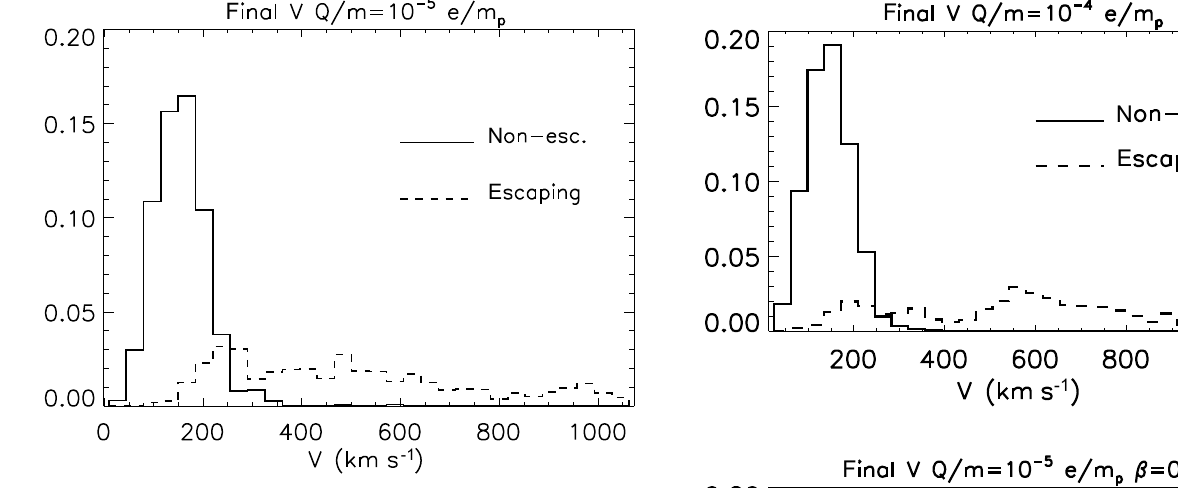
Figure 4. Distribution of the final velocity for non-escaping and es- caping particle populations obtained in the CME model for a sample of 4800 nanodust particles with Q/m = 10 − 5 e/m p .